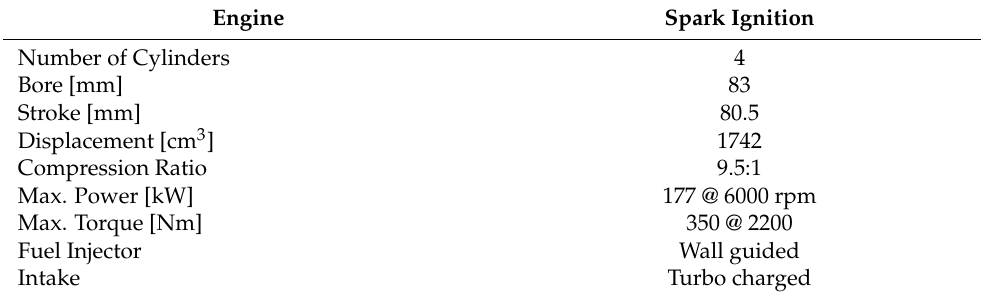
Table 1. Engine specifications.